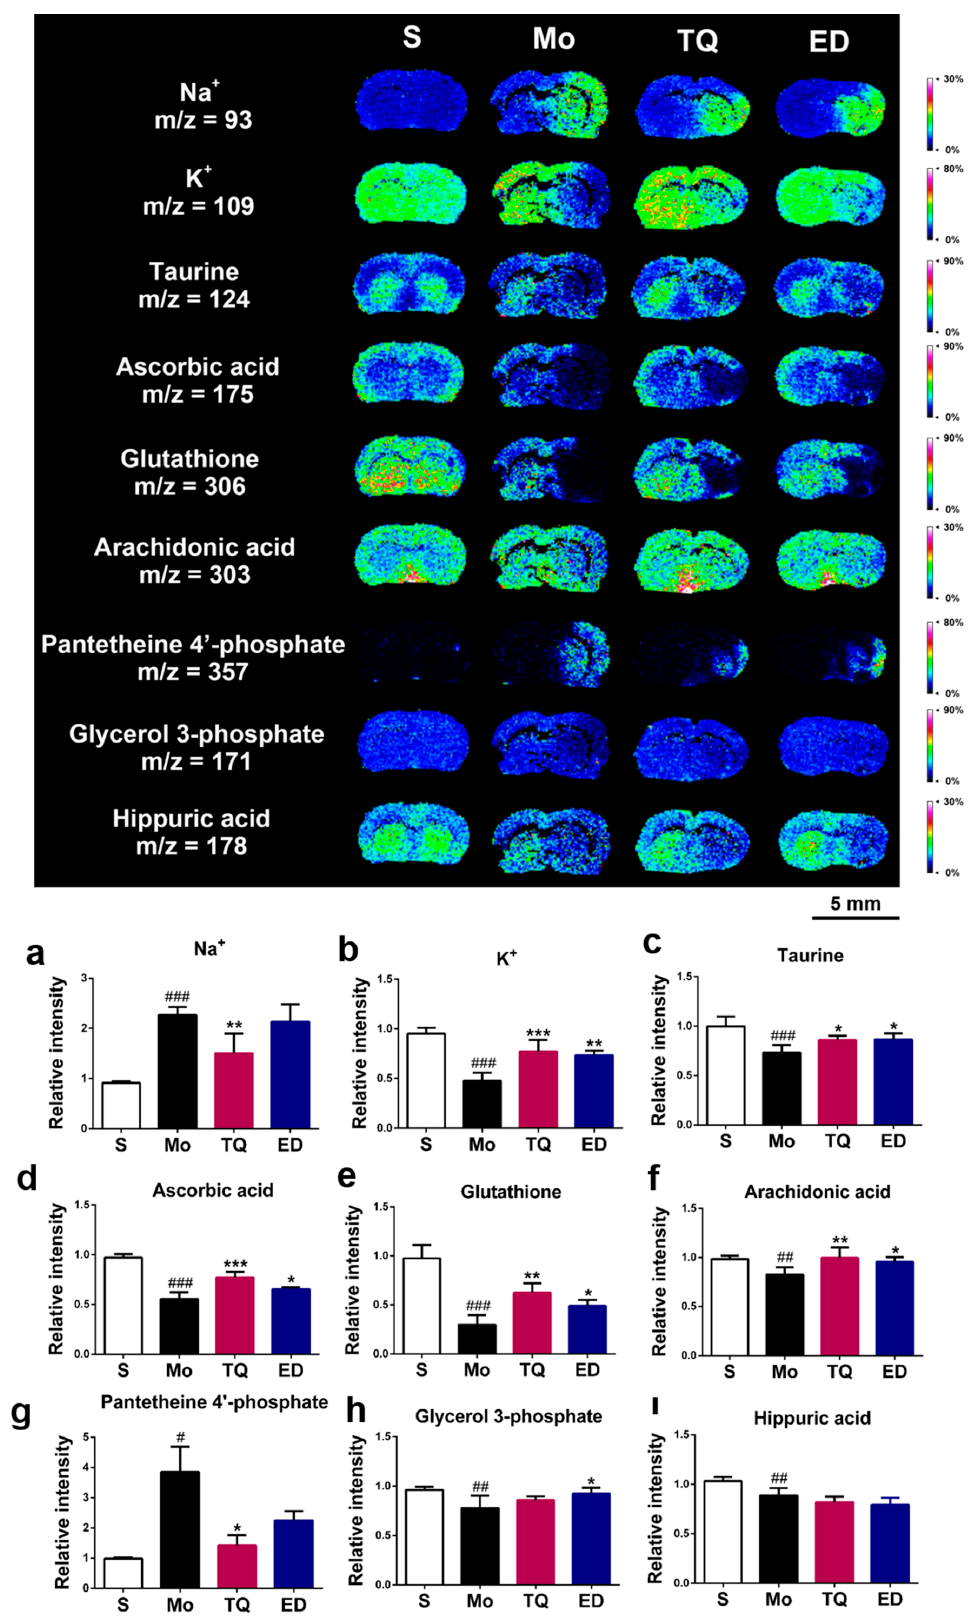
Figure 6. In situ matrix-assisted laser desorption ionization mass spectrometry imaging (MALDI-MSI) distribution and change in other metabolic molecules. ( a – i ) Statistical results of the relative changes